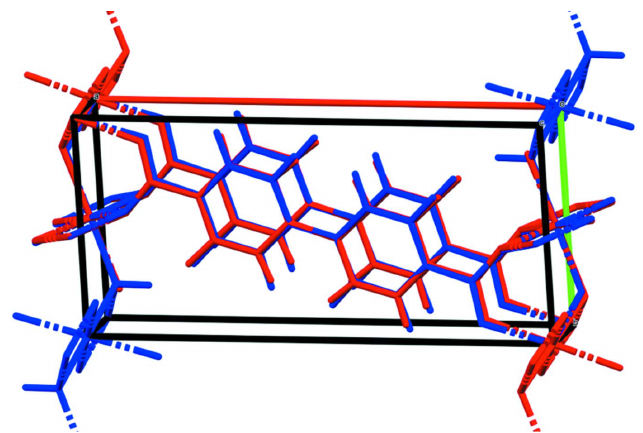
Figure 4 Comparison of the Rietveld-refined (red) and VASP -optimized (blue) structures of Mn 2 (BPDC)(OH) 2 . The r.m.s. Cartesian displacement is 0.133 A˚ . Image generated using Mercury (Macrae et al. , 2020).